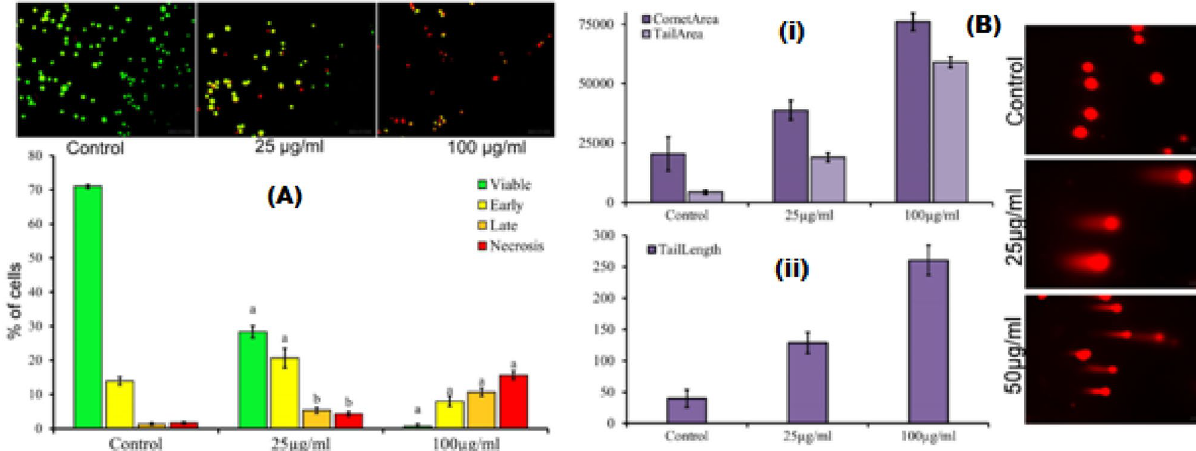
Figure 6. ( A ) Representative pictures of apoptosis assay of SAPE on MCF-7 with different doses (25, and100 µg/mL) or with 0.1% DMSO as the vehicle control for 48 h, determined by AO/EtBr dye staining; ( B ) Representative Comet images for DNA damage in of SAPE in MCF-7 cells detected by neutral comet assay, and quantification of the percentage of DNA damaged cells by measuring the (i) area of comet and (ii) length of comet tail with Open Comet software. Data represented as mean ± SEM. Values were significant at * P ≤ 0.05, ** P ≤ 0.01 and ***P ≤ 0.001 as compared to